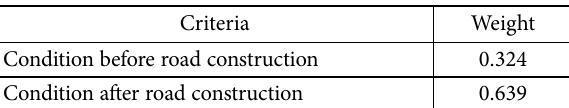
Table 5. Weights of the